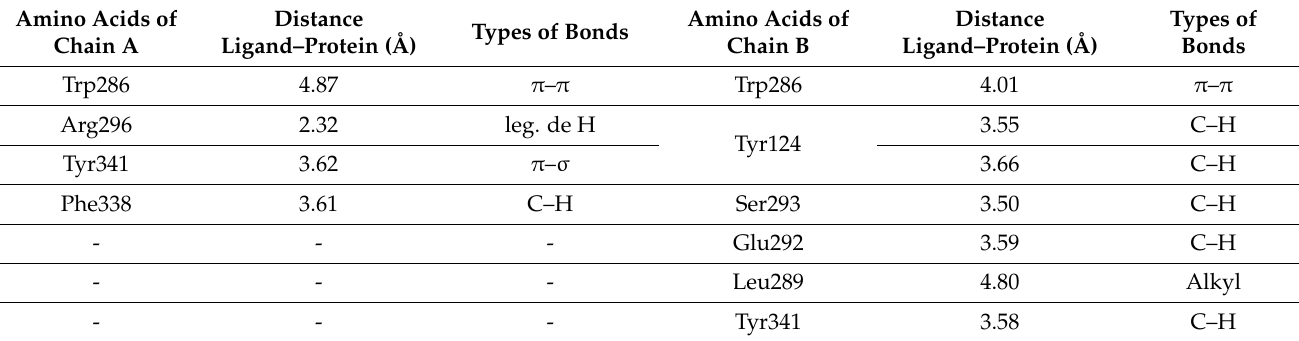
Table 2. Rivastigmine–AChE ligand–receptor interactions at the A and B